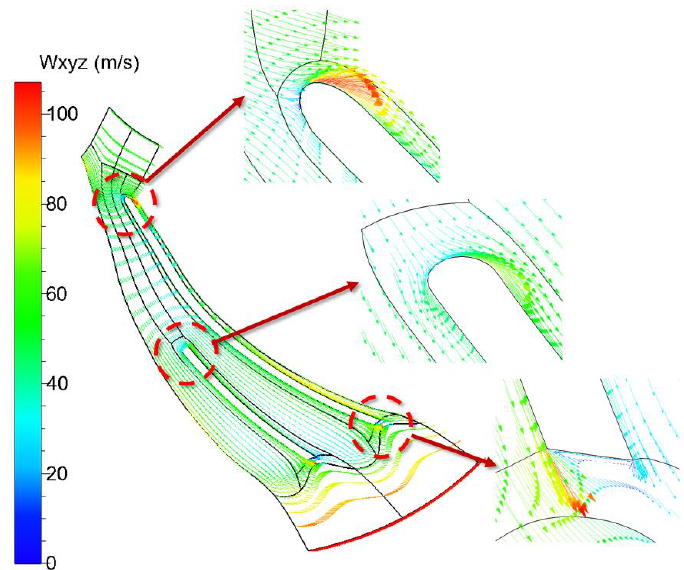
Figure 10. The velocity vector distribution of the 50% blade height section of the initial design.